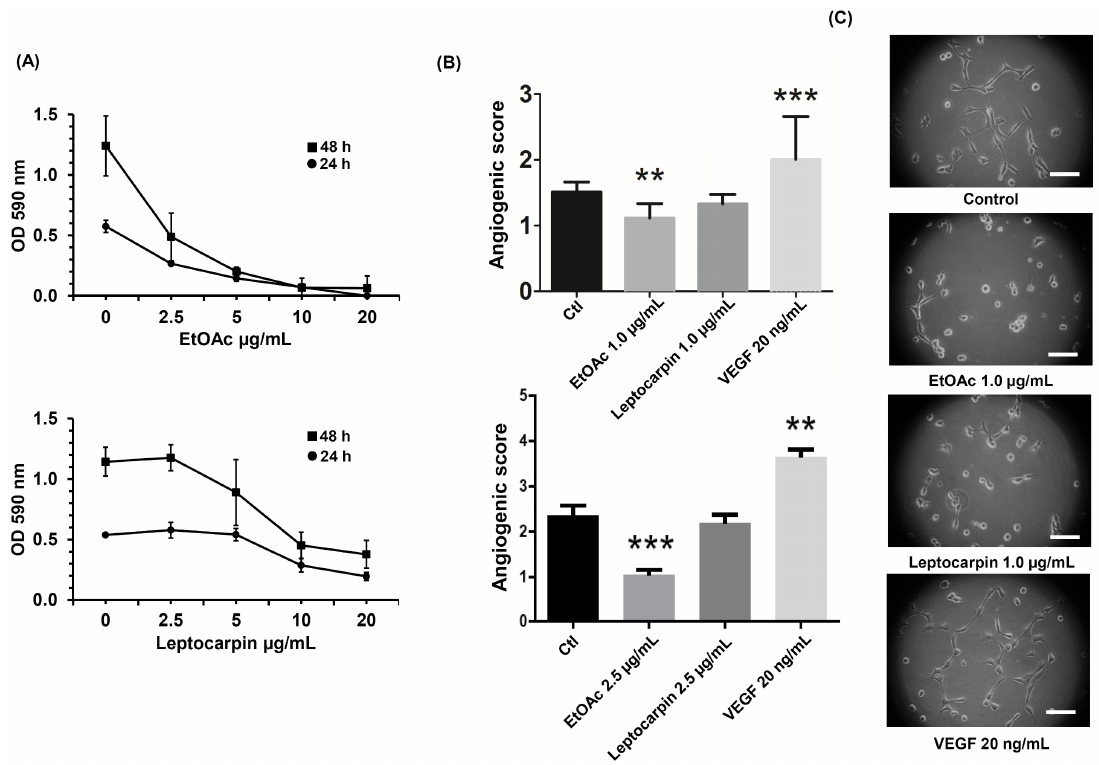
Figure 6. The EtOAc L. rivularis flower extract and leptocarpin reduce the vasculogenic capacity of EA.hy926 cells. ( A ) EA.hy926 cells were treated with different concentrations of the EtOAc extract or leptocarpin (0, 2.5, 5, 10, and 20 µ g/mL) for 24 h (circles) or 48 h (squares). Cell proliferation was evaluated with the MTS assay. Dose–response curves represent absorbance values at 490 nm from at least three independent experiments (means ± S.D.). ( B ) EA.hy926 cells were treated with the EtOAc extract (1.0 µ g/mL and 2.5 µ g/mL) or leptocarpin (1.0 µ g/mL and 2.5 µ g/mL) for 24 h and then seeded in Matrigel-coated plates and cultured for an additional period of 24 h. Bars represent the angiogenic scores obtained for each condition. Values represent the means ± S.D. from three independent experiments (** p < 0.01, and *** p ≤ 0.001 vs. the control condition). ( C ) Representative images of EA.hy926 cells cultured for 24 h on Matrigel-coated plates following EtOAc 1.0 µ g/mL, leptocarpin 1.0 µ g/mL, or VEGF 20 ng/mL treatments. Magnification bar = 50 µ